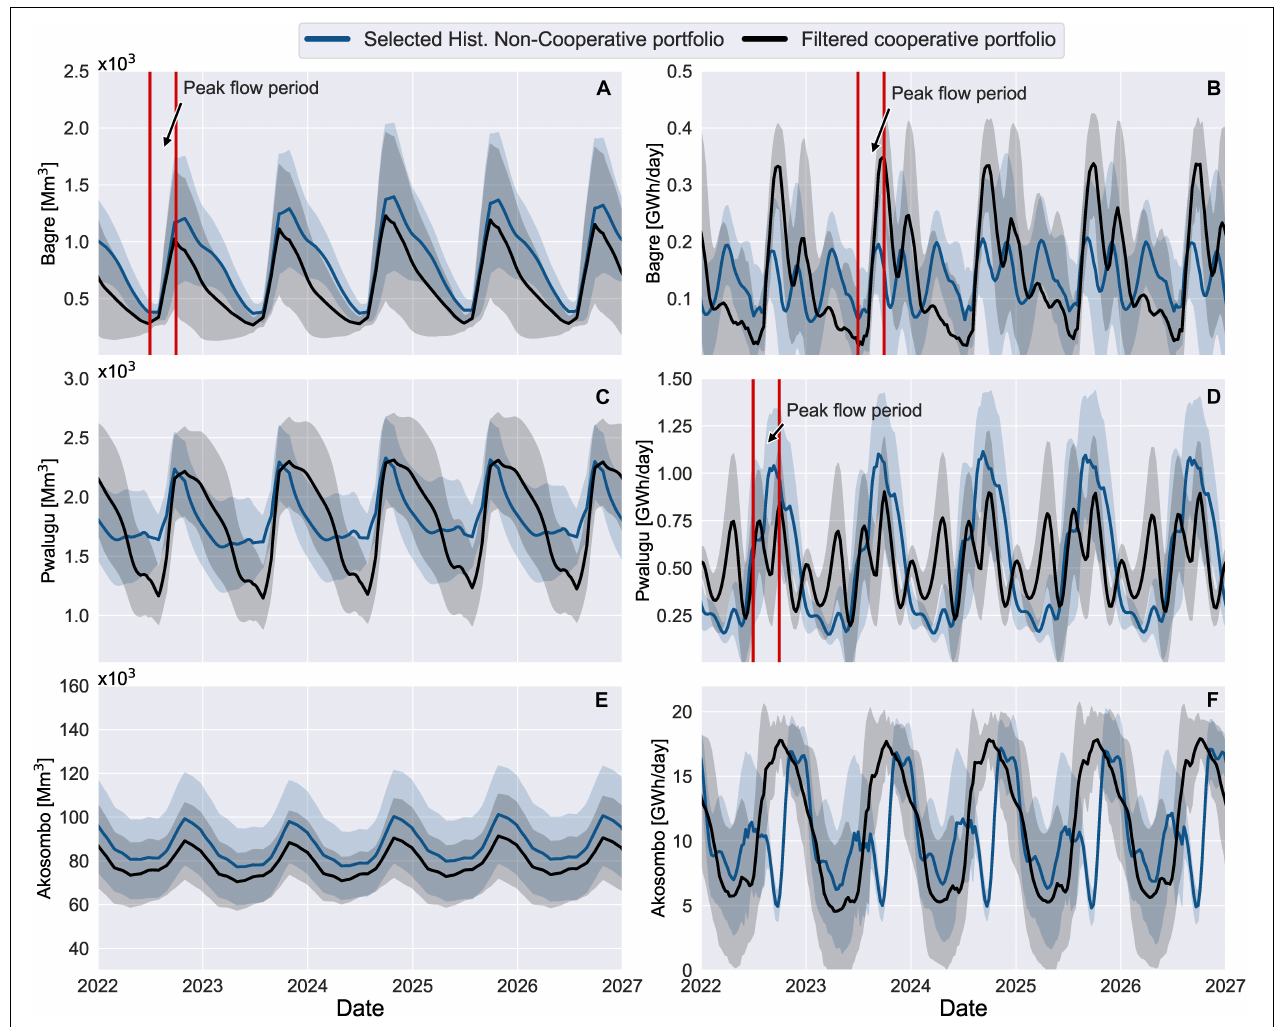
FIGURE 7 | Reservoirs operation. Panel (A,C,E) show the mean value under the hydrological scenarios and the standard deviation (light blue and grey area) of the stimulated reservoir volume in Bagre, Pwalugu, and Akosombo, respectively. Panel (B,D,F) show the mean value under the hydrological scenarios and the standard deviation of the simulated energy production for the Bagre, Pwalugu, and Akosombo dams,